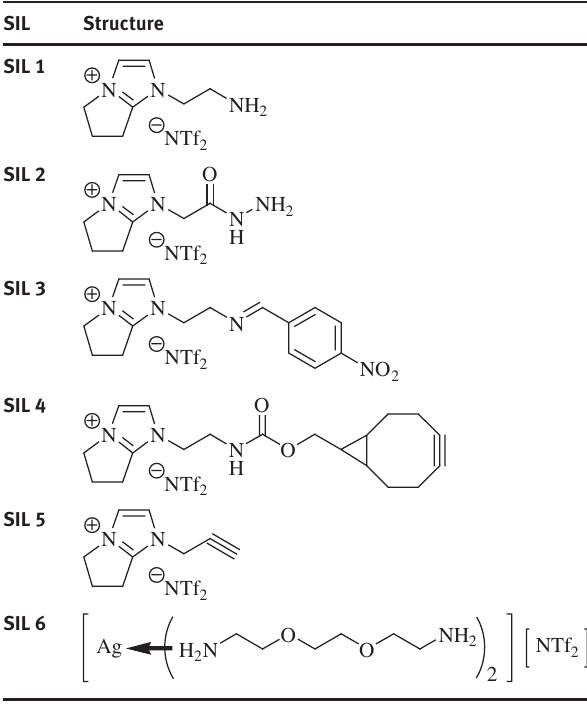
Table 1: Structures of